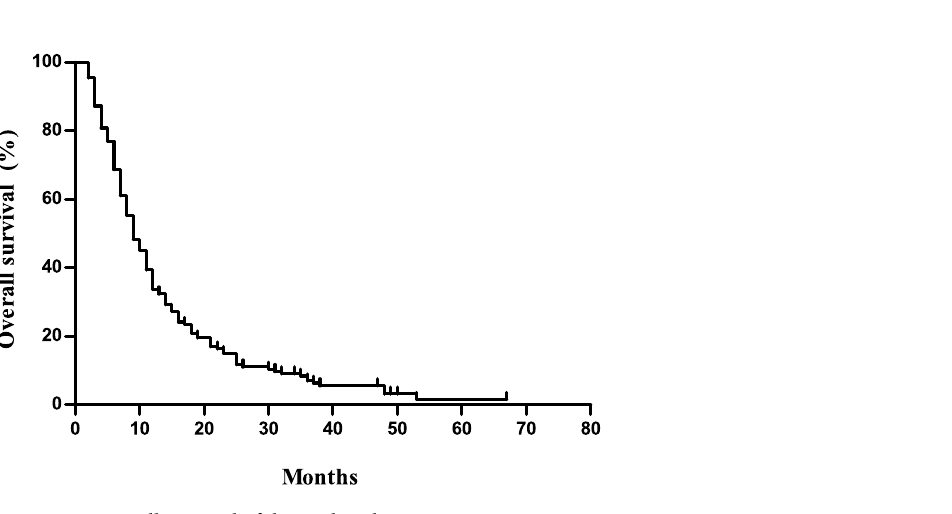
Figure 2. Overall Survival of the study